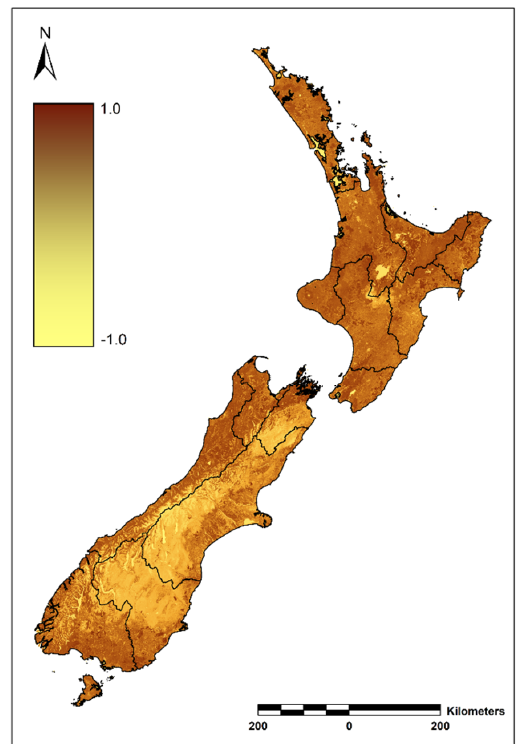
Figure 5. A national map of median NDVI, with regional boundaries drawn in black.